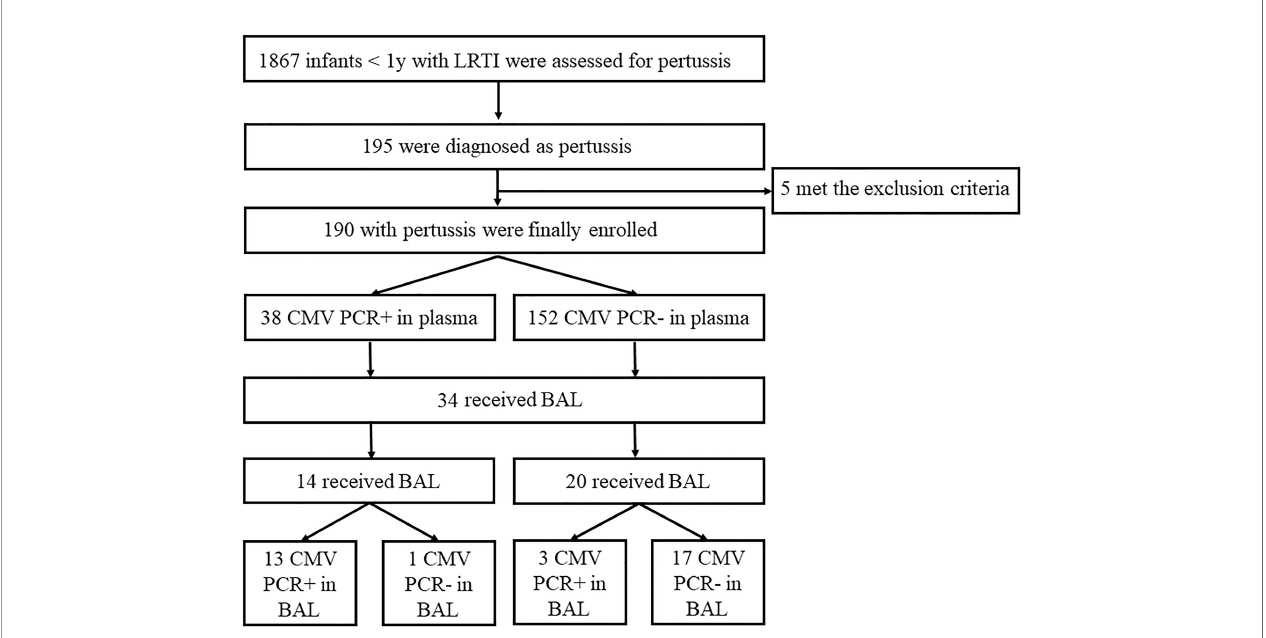
FIGURE 1 | Study enrollment and Final Pertussis and Cytomegalovirus (CMV) Cases. LRTI, low respiratory tract